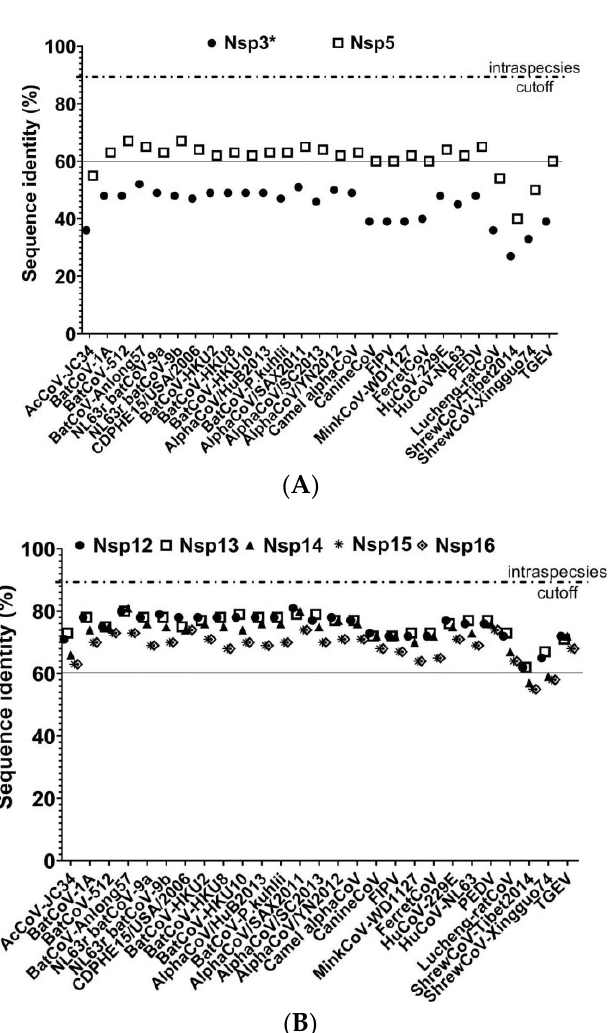
Figure 3. Amino acid sequence comparisons of conserved domains in replicated polyproteins between the HCQD-2020 strain and other alphacoronaviruses. The conserved regions of Nsp3 and Nsp5 in ORF1A ( A ) ad Nsp12–Nsp16 in ORF1b ( B ) were compared between HCQD-2020 strains and other reference strains.* For Nsp3: Only papain-like protease and ADP-ribose binding domains were applied for comparison. The solid lines are used to highlight the low similarity of Nsp3 and Nsp5 compared with the remaining. Nsps.